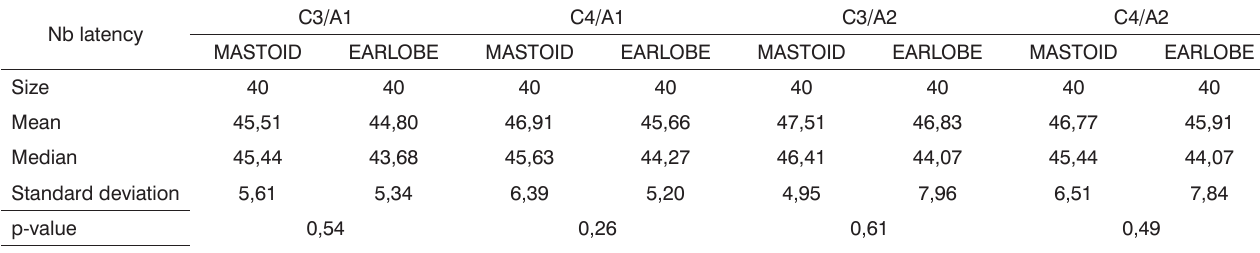
Table 5. Comparing Nb wave latencies in MLEAP C3/A1, C4/A1, C3/A2, C4/A2 modes, between Mastoid and Earlobe.